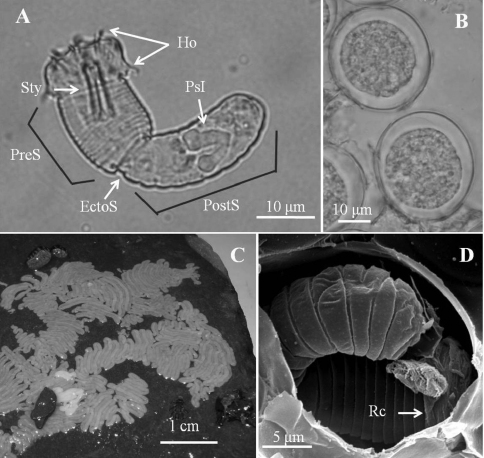
Eggs and larvae of Chordodes formosanus sp. n. A Live larva in water B eggs (6 days after being laid) C egg strings stuck onto a rock D larva in an egg with residual cuticle. EctoS, ectodermal septum; Ho, hooklet; PostS, postseptum; PreS, preseptum; PsI, pseudointestine gland; Rc, residual cuticle; Sty, stylet.